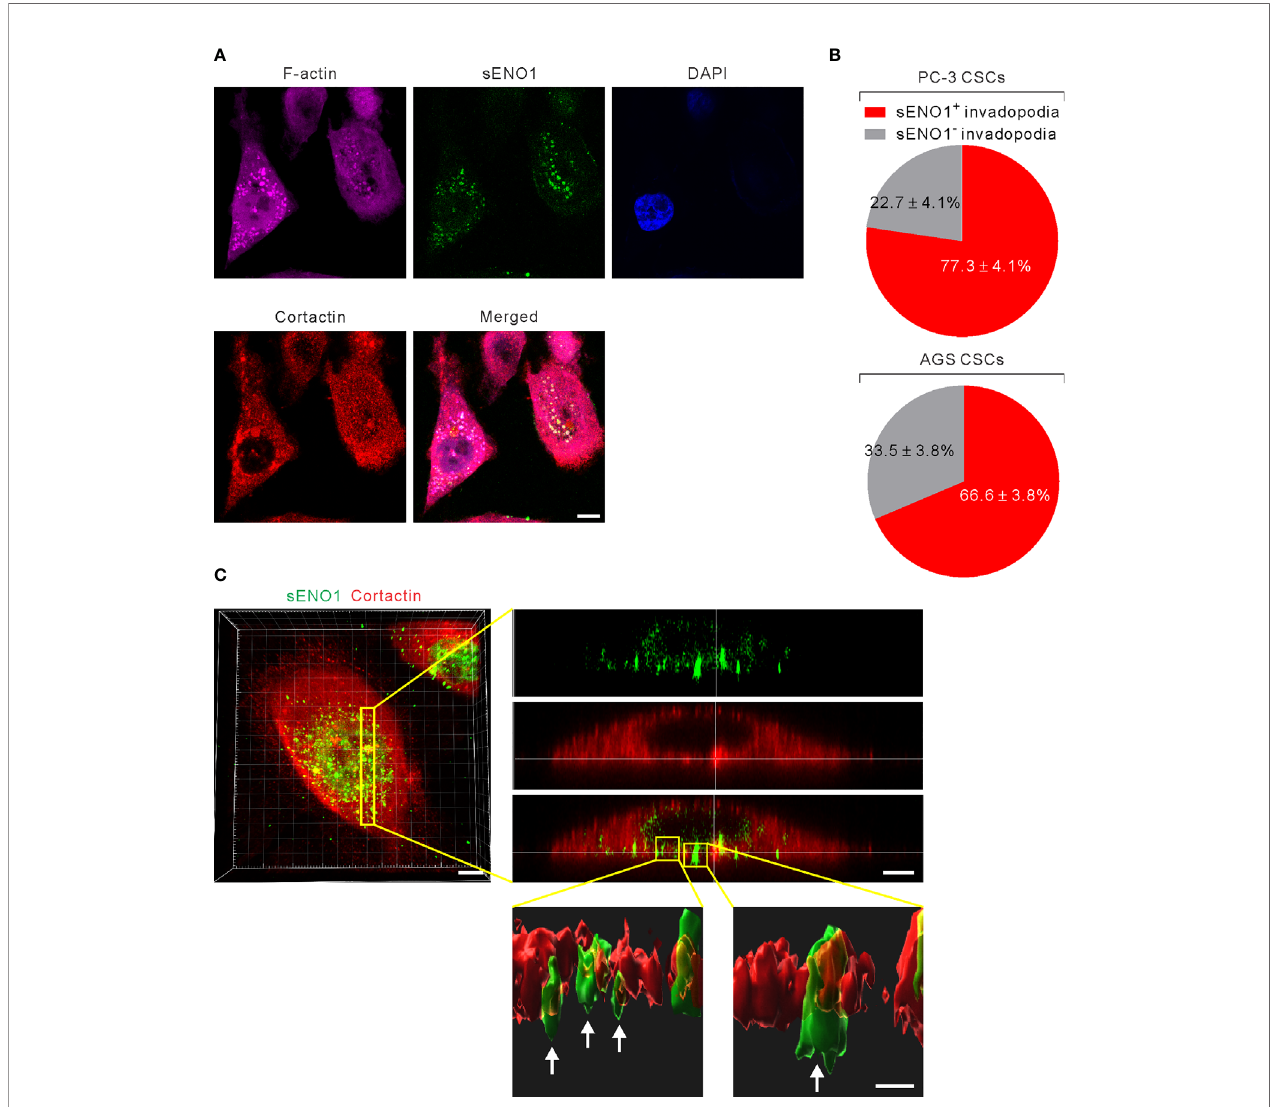
FIGURE 4 | ENO1 is expressed on the invadopodial surface of CSCs. (A) Confocal views of PAC CSCs (represented by CD44 + CD133 + PC-3 cells) showing the cross-section of invadopodia structures (represented by cortactin + F-acin + puncta) with the colocalized surface ENO1 (sENO1; green), cortactin (red), and F-actin (magenta) that penetrate into the underlying gelatin matrix. Nuclei were counterstained with 4 ’ ,6-diamidino-2-phenylindole (DAPI; blue). Scale, 10 m m. (B) Top, a pie chart showing the percentage of sENO1 + invadopodia per PC-3 CSC. Bottom, a pie chart showing the percentage of sENO1 + invadopodia per GAC AGS CSC (represented by CD90 + AGS cells). (C) Left, representative three-dimensional (3D) reconstructed confocal image of CD44 + CD133 + PC-3 CSCs showing the colocalization of sENO1 (green) and cortactin (red) at the ventral side of cell. Scale, 8 m m. Right upper, digital zoom-in image from serial Z sections (yellow rectangle) showing the spatial colocalization of sENO1 (green) and cortactin (red) at invadopodia. Scale, 5 m m. Right lower, the orthogonal view of the magni fi ed areas (yellow squares at top) shown the distribution and localization of sENO1 and cortactin at the base of invadopodia. 3D rendered images of the invadopodia (arrows) were processed by using Imaris software. Scale, 1 m